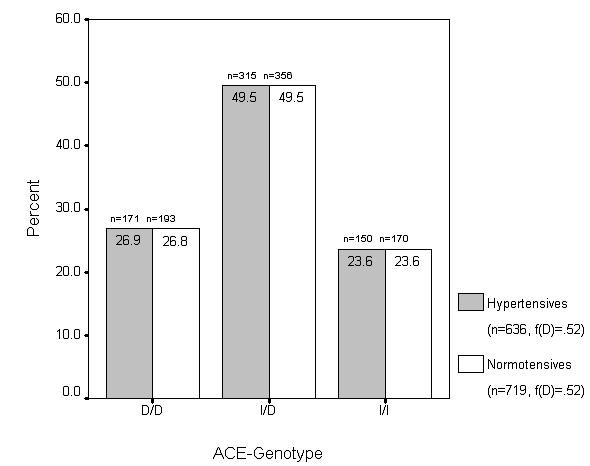
ACE genotypes and allele frequencies, both genders combined. No significant differences. F(D): frequency of D- allele.